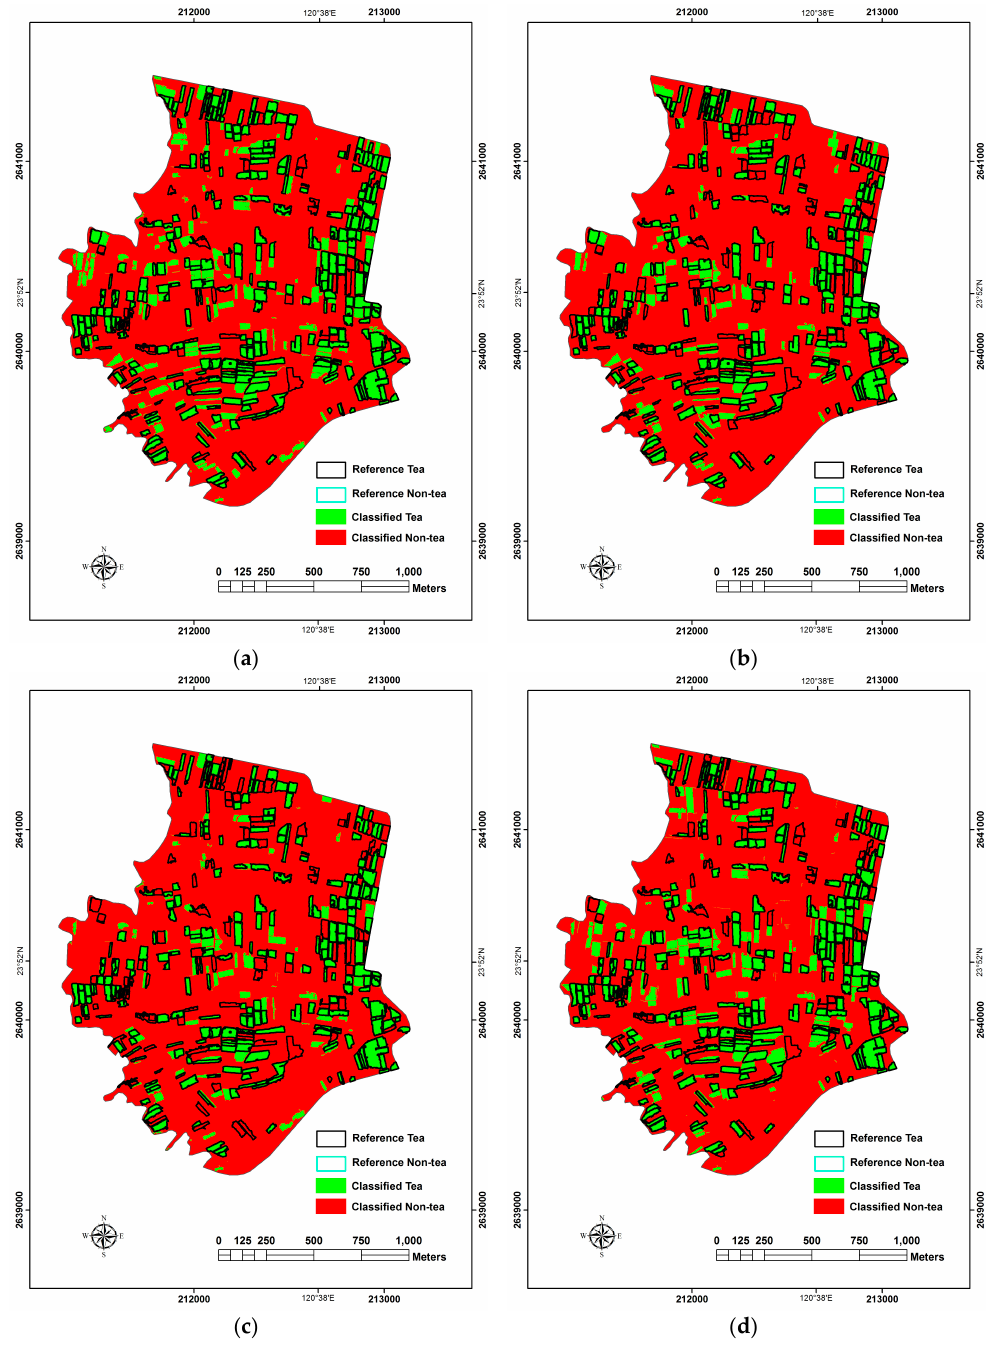
Figure 7. The results of OBIA classification. ( a ) ML; ( b ) LR; ( c ) RF; ( d ) SVM.